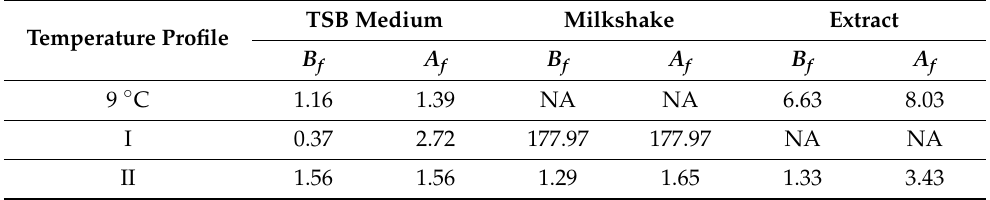
Table A6. Bias factor ( B f ) and Accuracy factor ( A f ) for TSB medium, goji berry milkshake, and goji berry extract in temperature profile I and in temperature profile